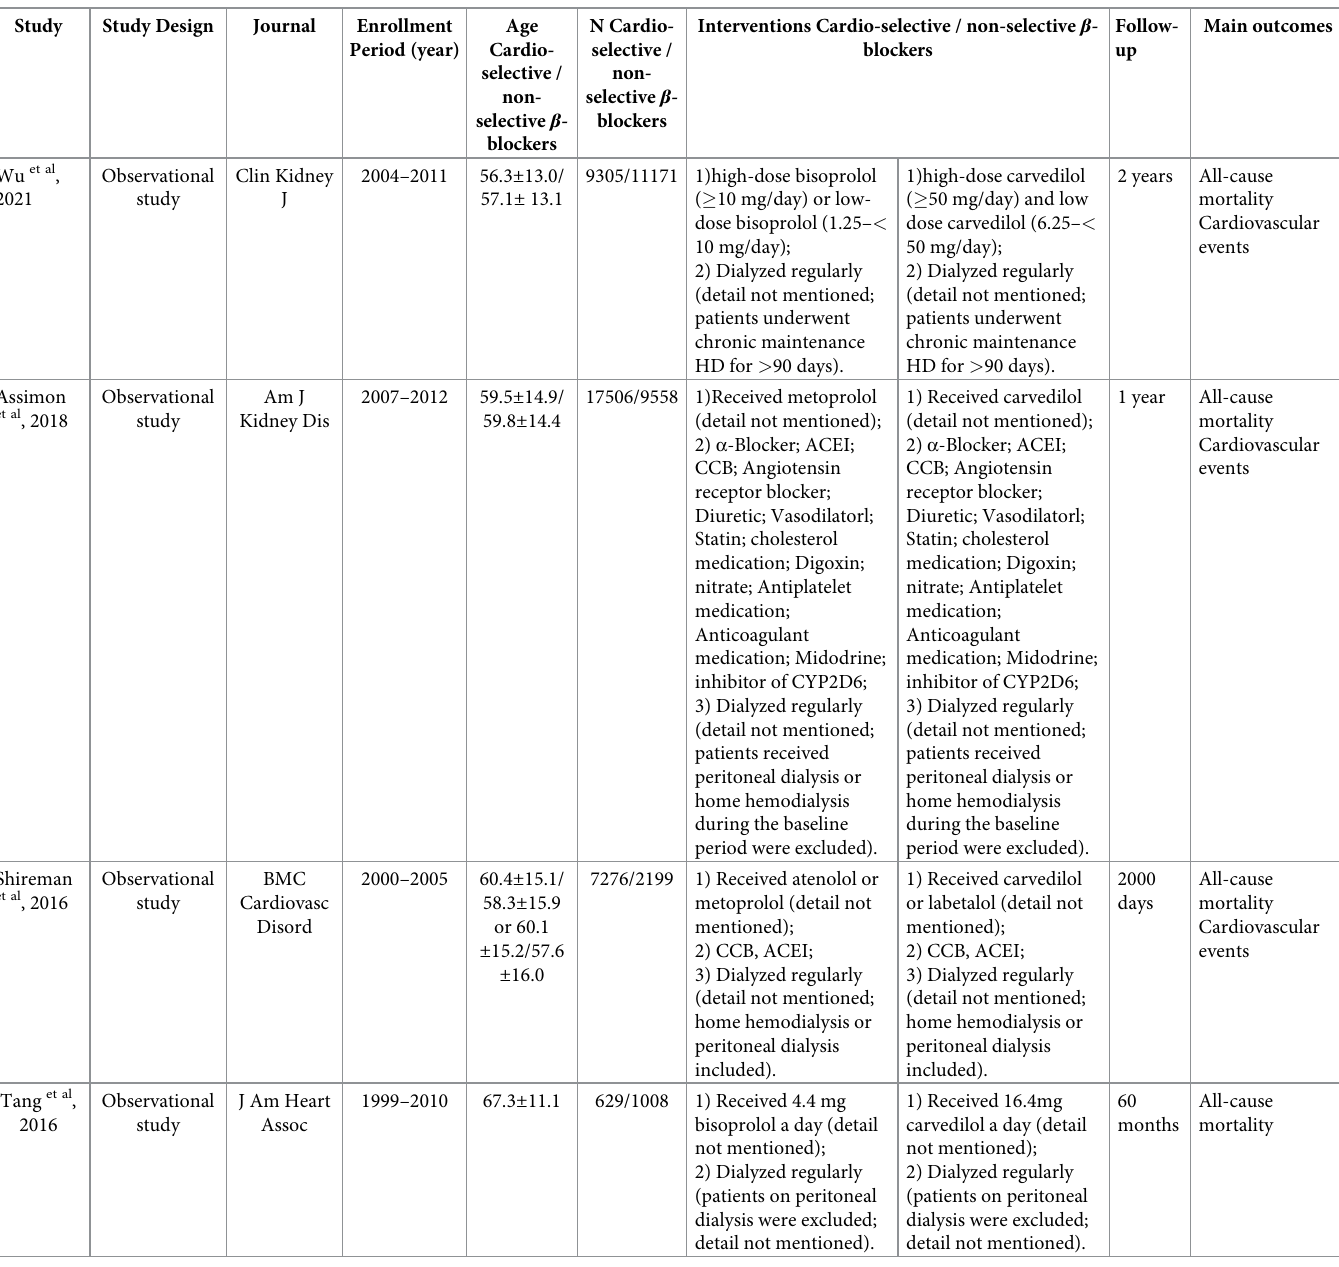
Table 1. General characteristics of all included